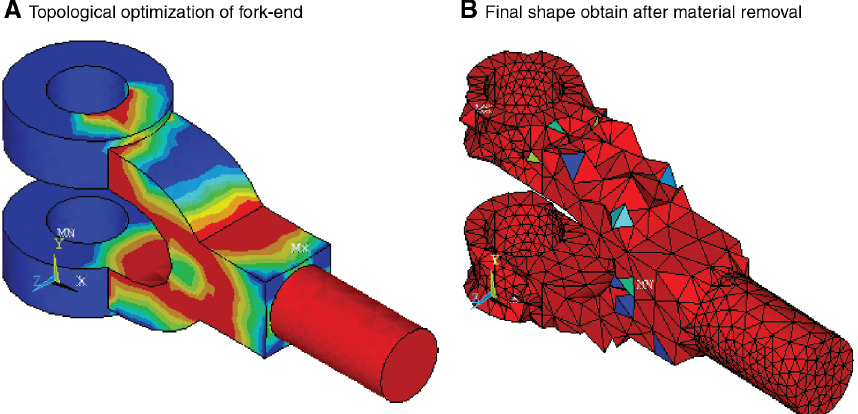
Figure 4: Displacement and stress distribution in the fork end of a knuckle